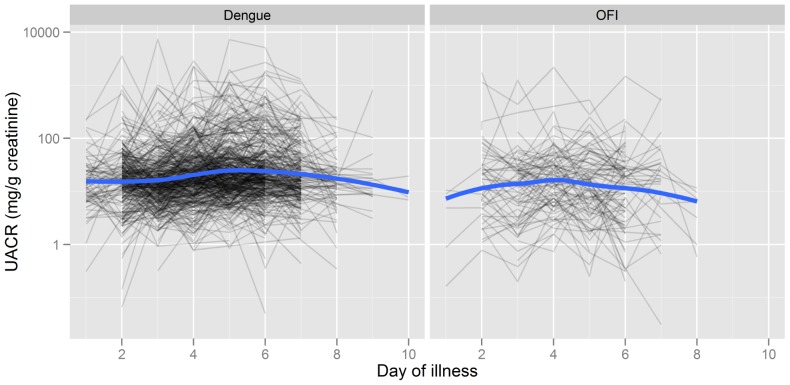
Longitudinal dynamics of UACRs in the confirmed dengue and OFI patient groups.All patients from Clinic A, and the confirmed dengue patients from Clinic B, are included. A significant time trend was observed in the dengue patients (p<0.0001), peaking on day 5 of illness, but no trend was apparent in the OFI patients (p = 0.22). The grey lines represent the evolution of the UACRs over time for each patient. The blue lines correspond to loess scatter plot smoothers.